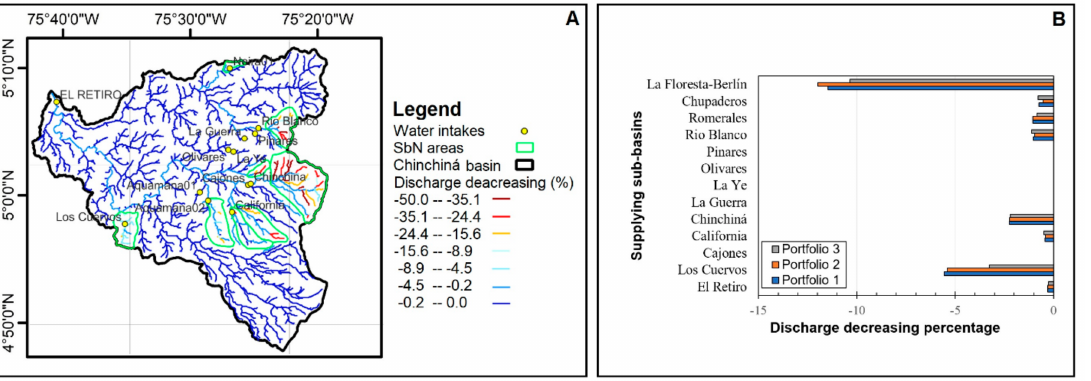
Figure 13. Changes in river discharges due to the implementation of NbS estimated using the TETIS models implemented for the Chinchin á river basin with the WMF utilities. Map ( A ) presents the spatial distribution of average discharge decreases simulated for trend scenarios (without imple- menting NbS) and scenario 1. The colors represent the estimated discharge decreasing percentage for a given stream NbS implementation areas. Plot ( B ) shows the estimated discharge decreasing percentage aggregated in the sub-basin areas, depending on the modeling scenarios constructed for each conservation